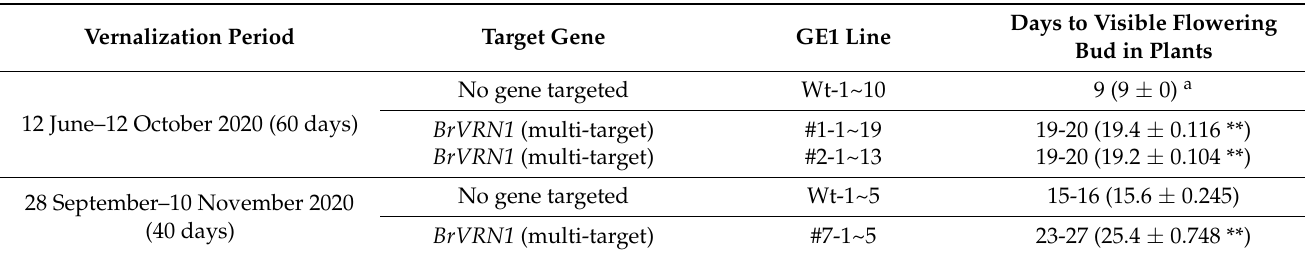
Table 1. Phenotypes of flowering time in Chinese cabbage GE1 (T 1 ) mutant plants after vernalization. GE1 mutant plants were exposed to low temperature (4 °C) for 40 or 60 days.